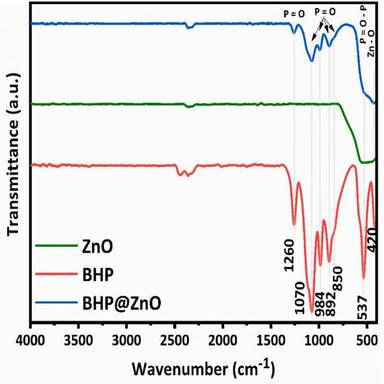
FT-IR analysis of ZnO, BHP and BHP@ZnO thin films.